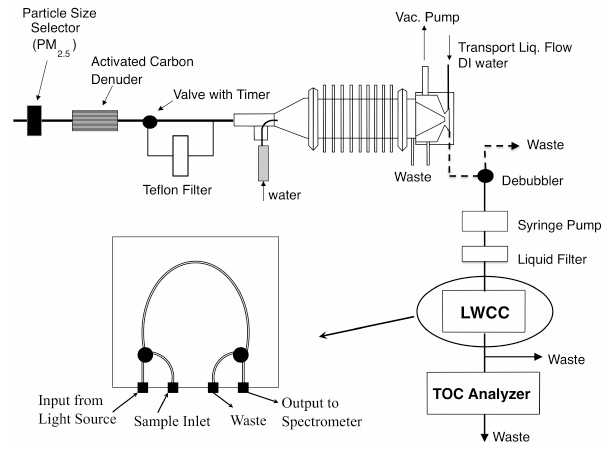
Fig. 2. Schematic of the online light absorption and WSOC mea- surement